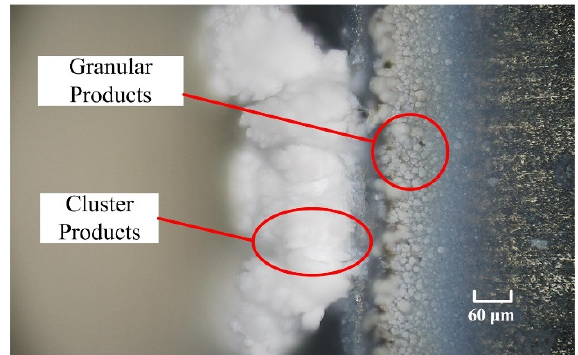
Figure 4. Magnification of area A in Figure 3d.